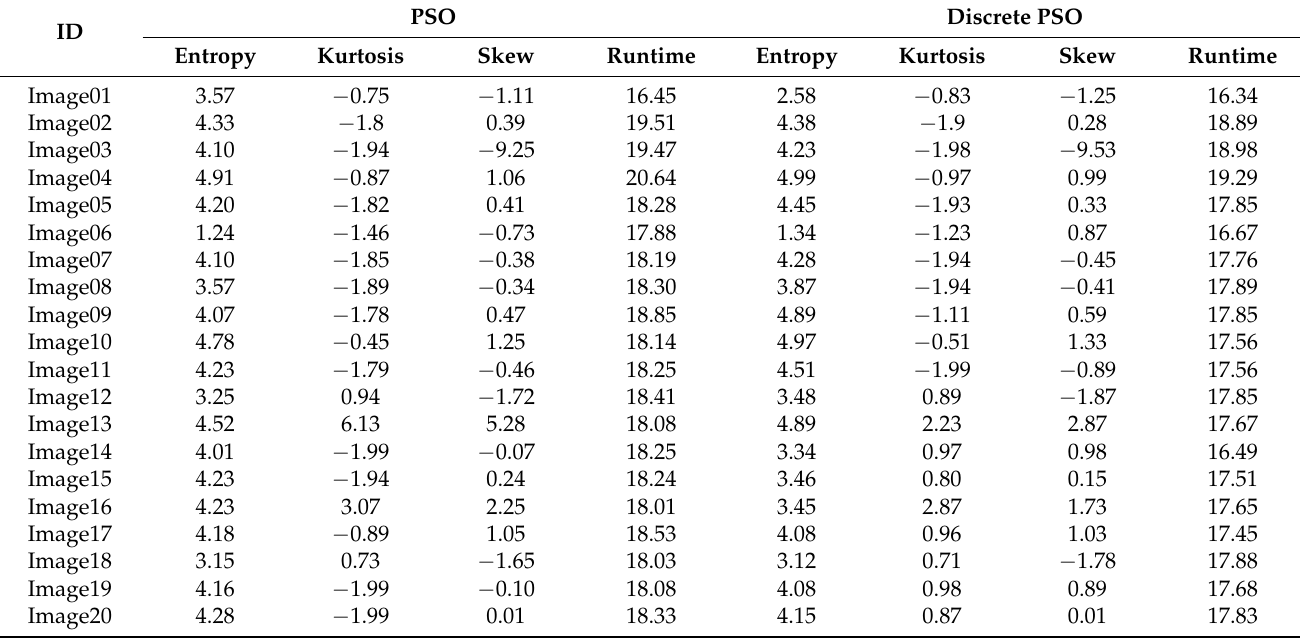
Table 3. Similarity measures on the segmented image.